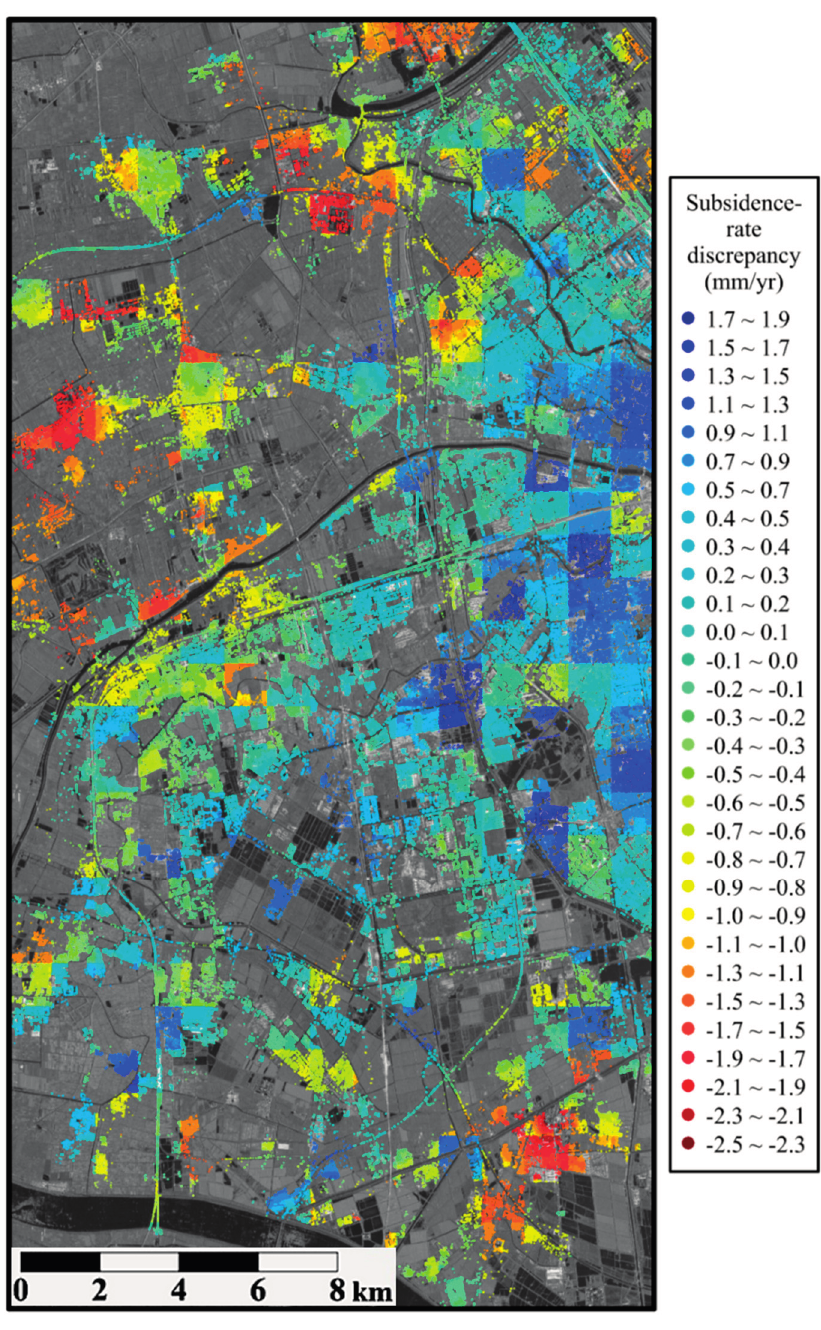
Figure 8. The distribution of discrepancies of subsidence rates at all the PSs between two types of solutions based on the global control network plus localized triangular irregular networks and the global triangular irregular network,